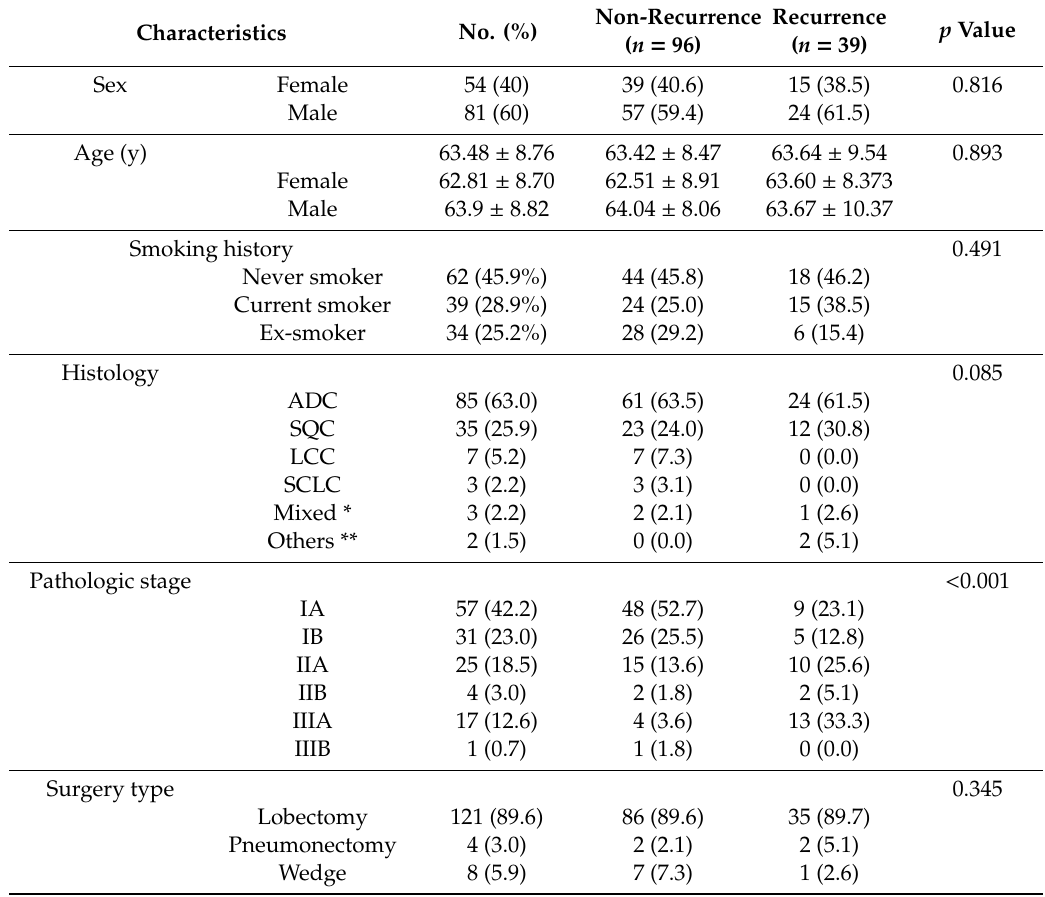
Table 1. Baseline demographics (N =